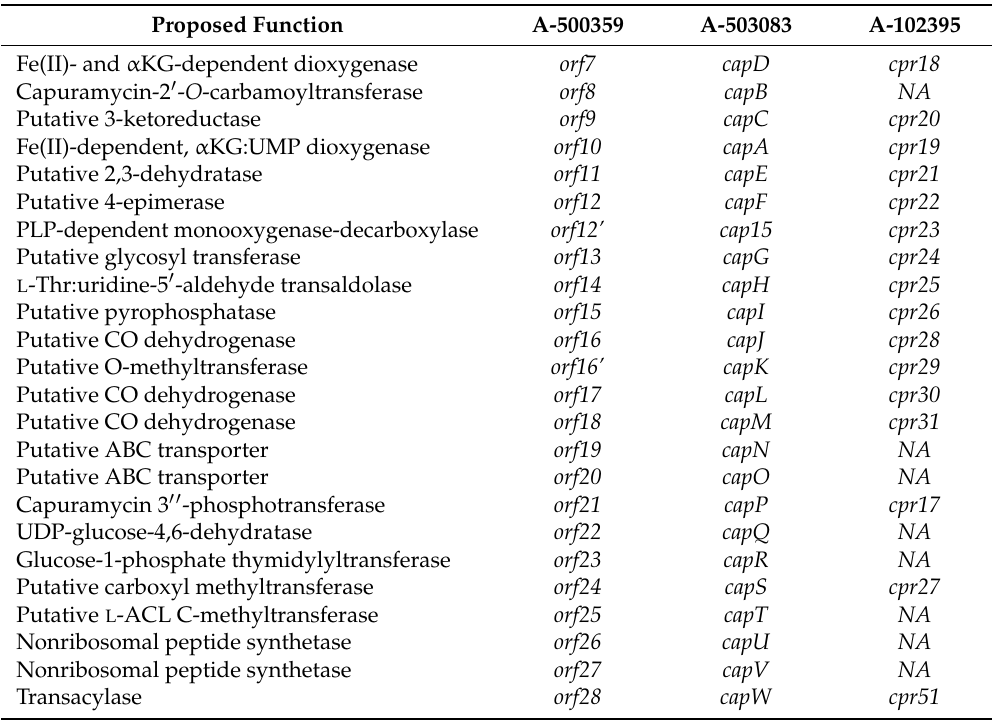
Figure 4. Figure 4. Depiction of the genetic organization of the biosynthetic gene clusters for the capuramycin- type nucleoside. Table 1. Shared orfs within the cloned biosynthetic gene Table 1. Shared orfs within the cloned biosynthetic gene clusters.